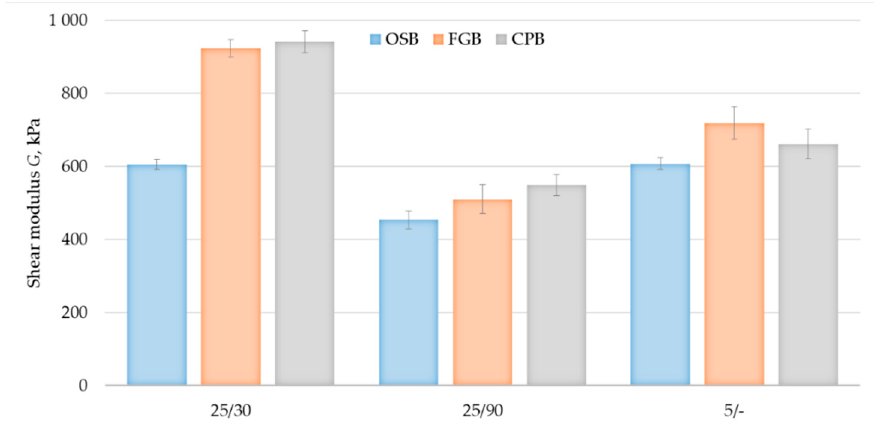
Figure 12. Shear modulus tests results of bonds made under different thermal and moisture condi- tions (error bars show standard deviation values).